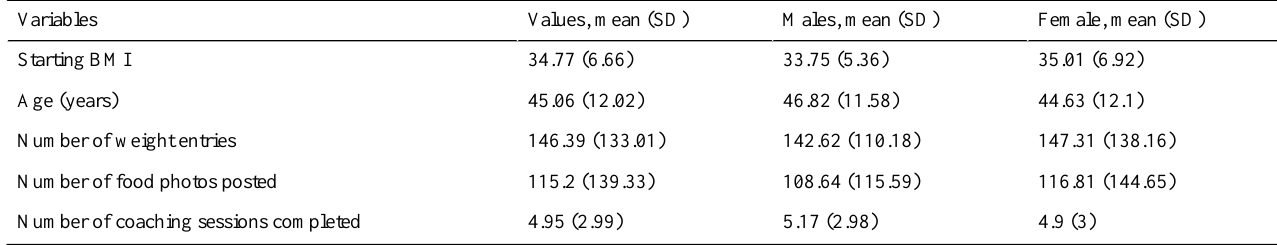
Table 2. Mean demographic and engagement variables overall and by